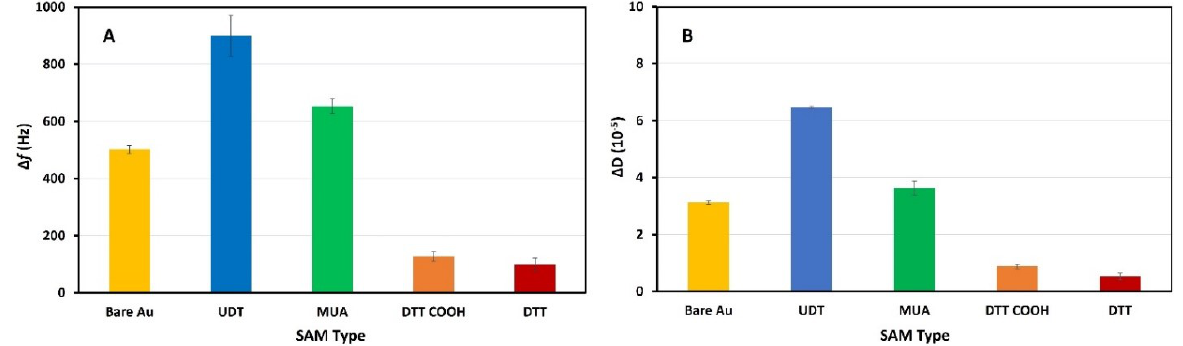
Figure 12. Frequency ( A ) and dissipation ( B ) shift of QCM crystals with different SAM coatings after exposure to undiluted human serum.